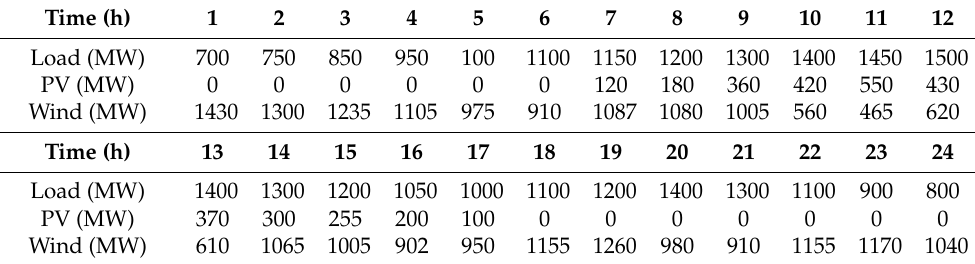
Table 5. Hourly data of PV power, wind power, and load demand in one day. Time (h)